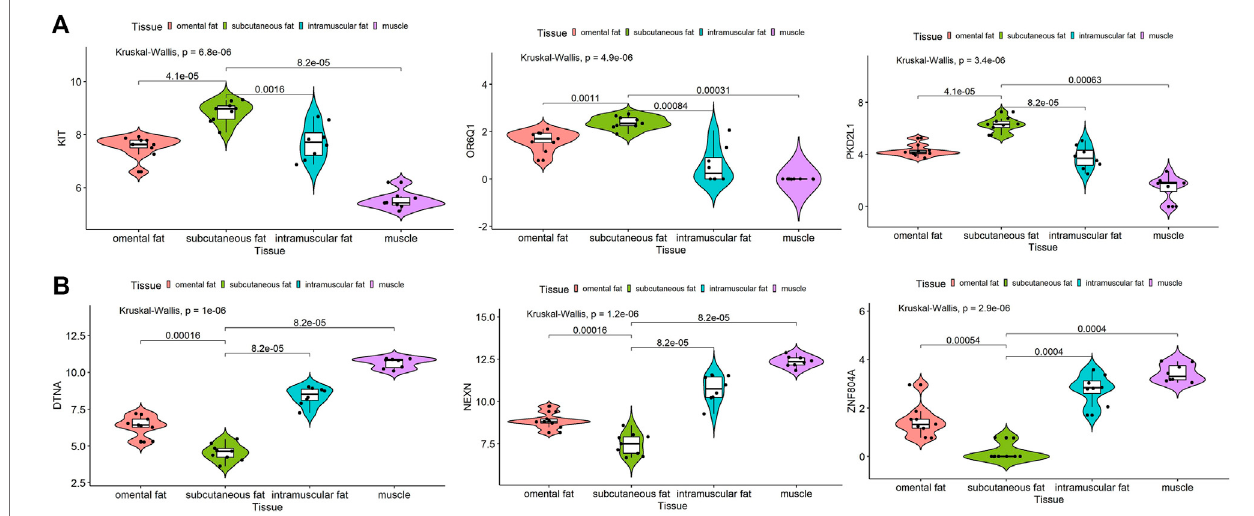
FIGURE 10 | Expression analysis of hub genes in intramuscular and omental fat. Expression levels of PTGS2 and IL6 (A) were signi fi cantly increased in intramuscular fat, and WT1 and ARHGEF5 (B) were signi fi cantly increased in omental fat.